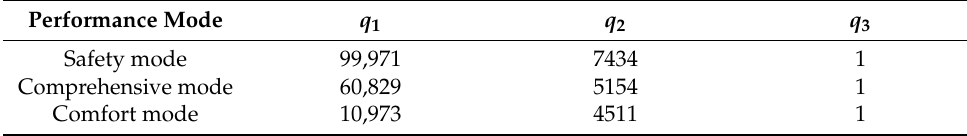
Table 10. The optimal solution of the three performance